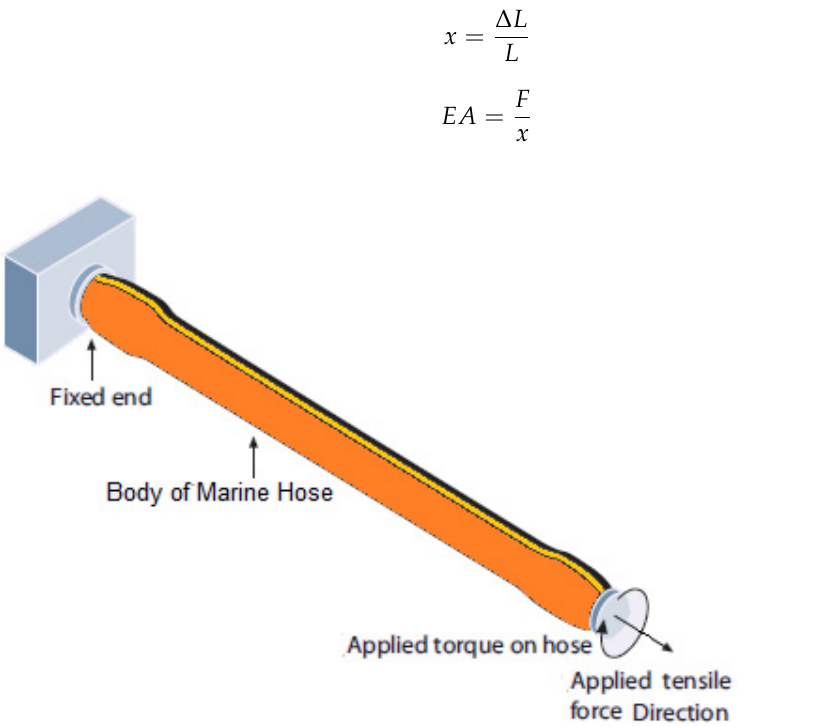
Figure 25. Illustration of torsion and tensile tests on marine hose.